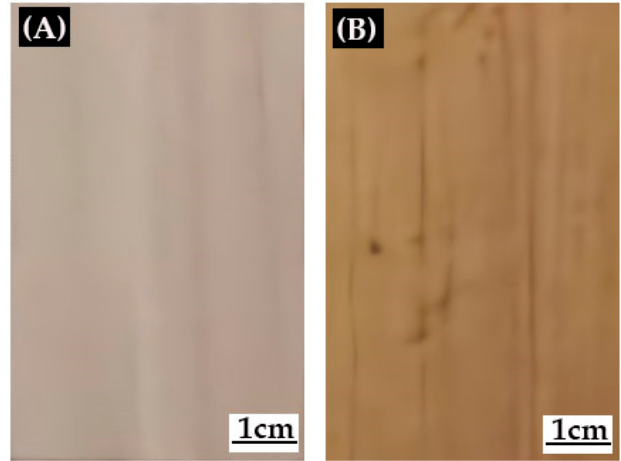
Figure 1. Modified poplar ( A ) and poplar brushed Didebao prime ( B ) (specimen size 150 mm × 80 mm × 20 mm).